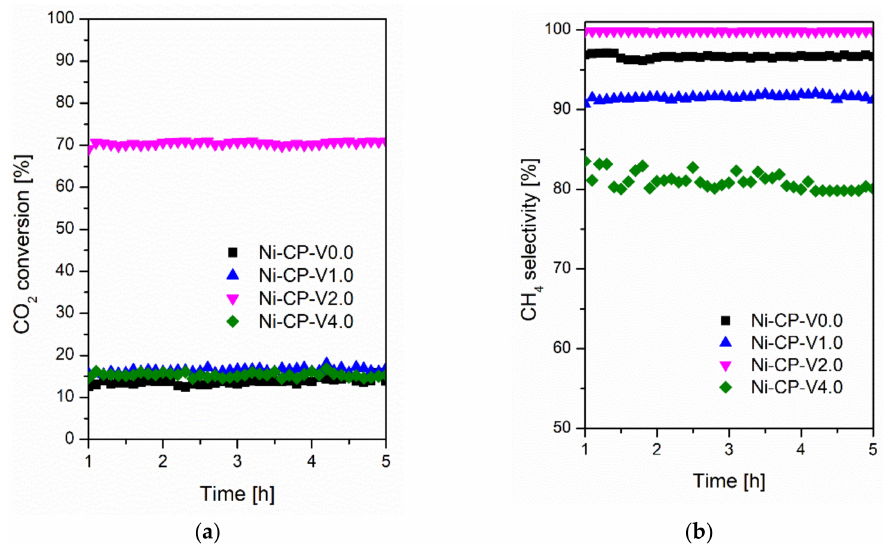
Figure 2. ( a ) CO 2 conversion as a function of time at 300 ◦ C; ( b ) CH 4 selectivity as a function of time at 300 ◦ C for hydrotalcite-based catalysts.